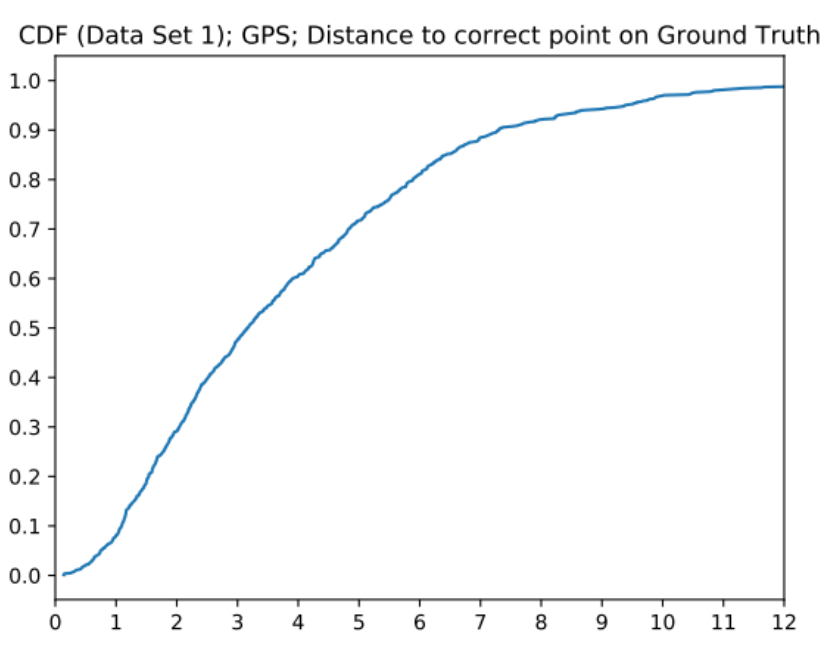
Figure 14. GPS error CDF of distance to correct point on the ground truth. Table 2. Evaluation (Dataset 1): GPS and AR; distance to correct point on the ground